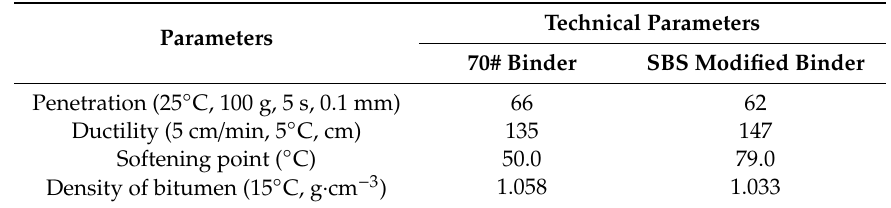
Table 2. Asphalt properties.